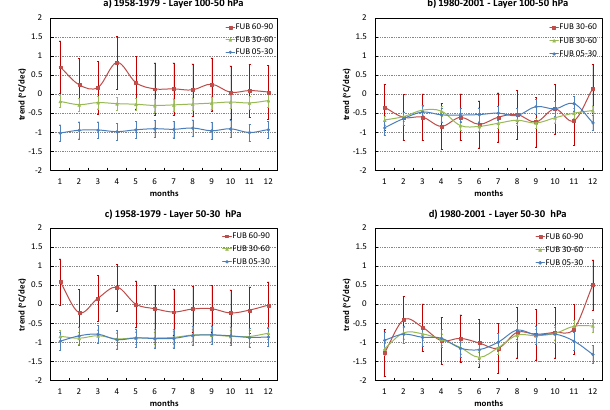
Figure 5. Mean temperature trends ( ◦ Cdecade − 1 ) for each month Figure 5 ( x axis) based on FU-Berlin data set over the periods 1958–1979 and 1980–2001 for the layers 100–50hPa ( a and b ) and 50–30hPa ( c and d ) for the three latitudinal belts: 5–30 ◦ N (blue), 30–60 ◦ N (green) and 60–90 ◦ N (red).